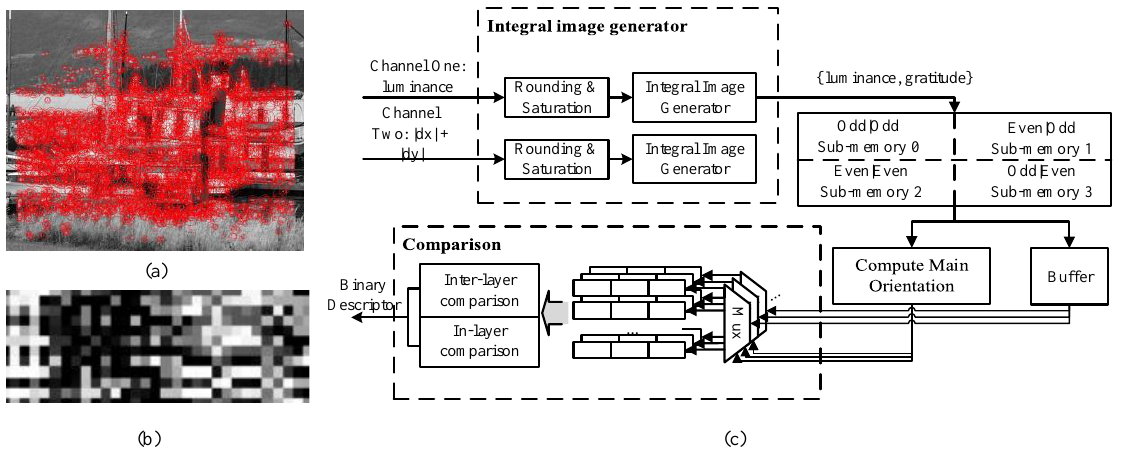
Figure 9. ( a ) An example of the input sublevel with key points detected; ( b ) An example of the binary descriptors in which each grid represents eight binary bits; ( c ) Block diagram